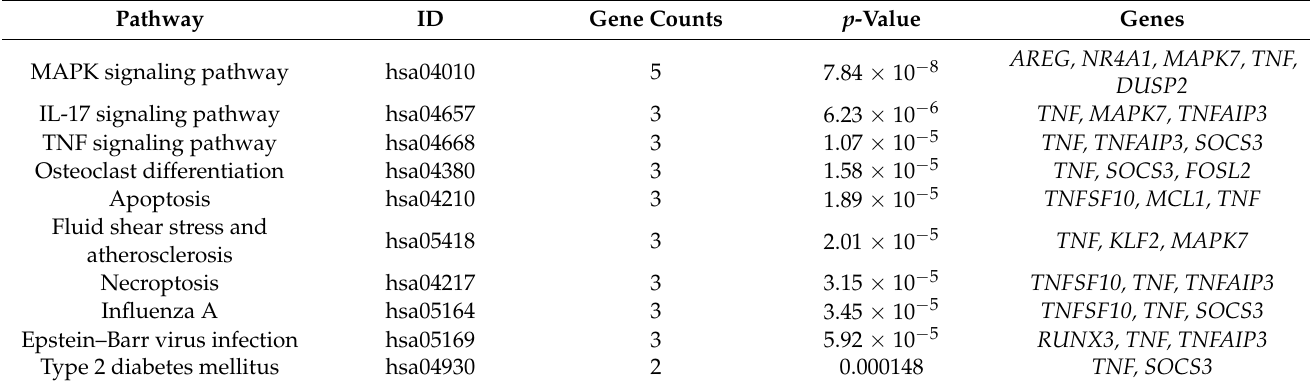
Table 5. Kyoto Encyclopedia of Genes and Genomes (KEGG) pathway analysis of Module.